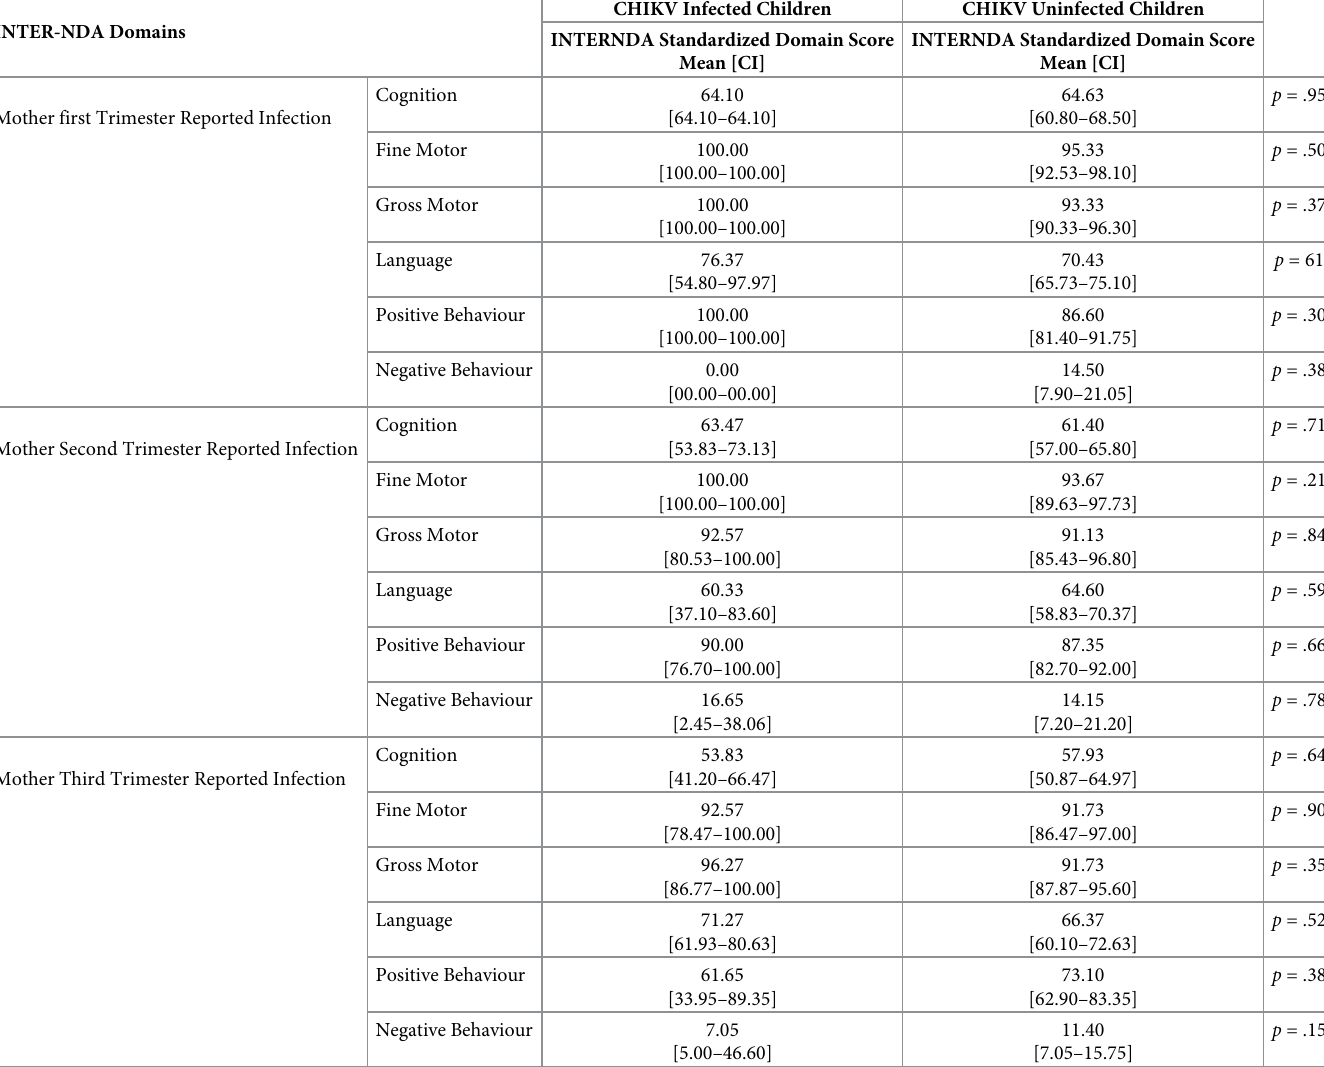
Table 9. Mean differences on normative standardized INTER-NDA domain scores between children born to mothers CHIKV infected in first, second, and third trimester. INTER-NDA